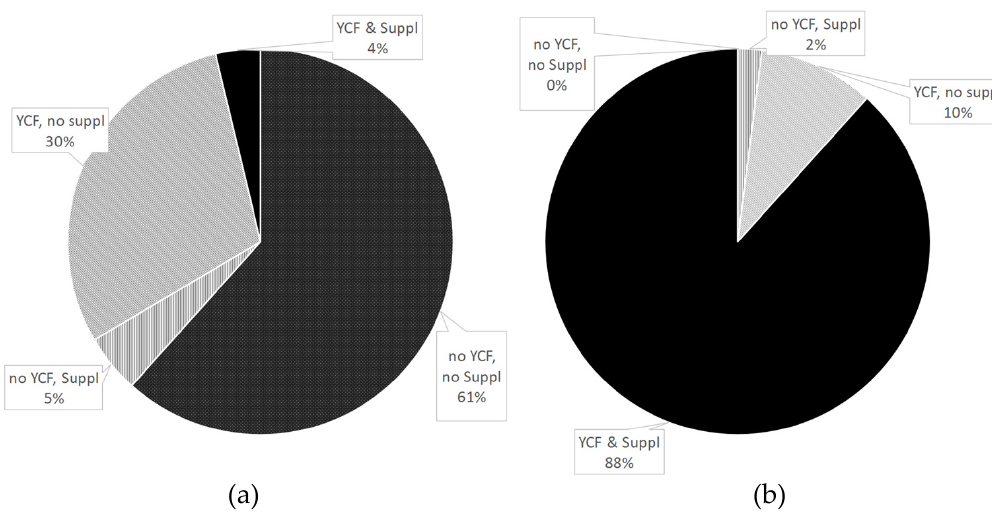
Figure 4. Percentage of diets containing YCF and/or supplement in ( a ) observed diets and ( b ) diets modeled with all ‐ foods models a . a “All ‐ foods models” refers to the linear programming models where all of the foods reported as consumed by the sample were taken as variables.